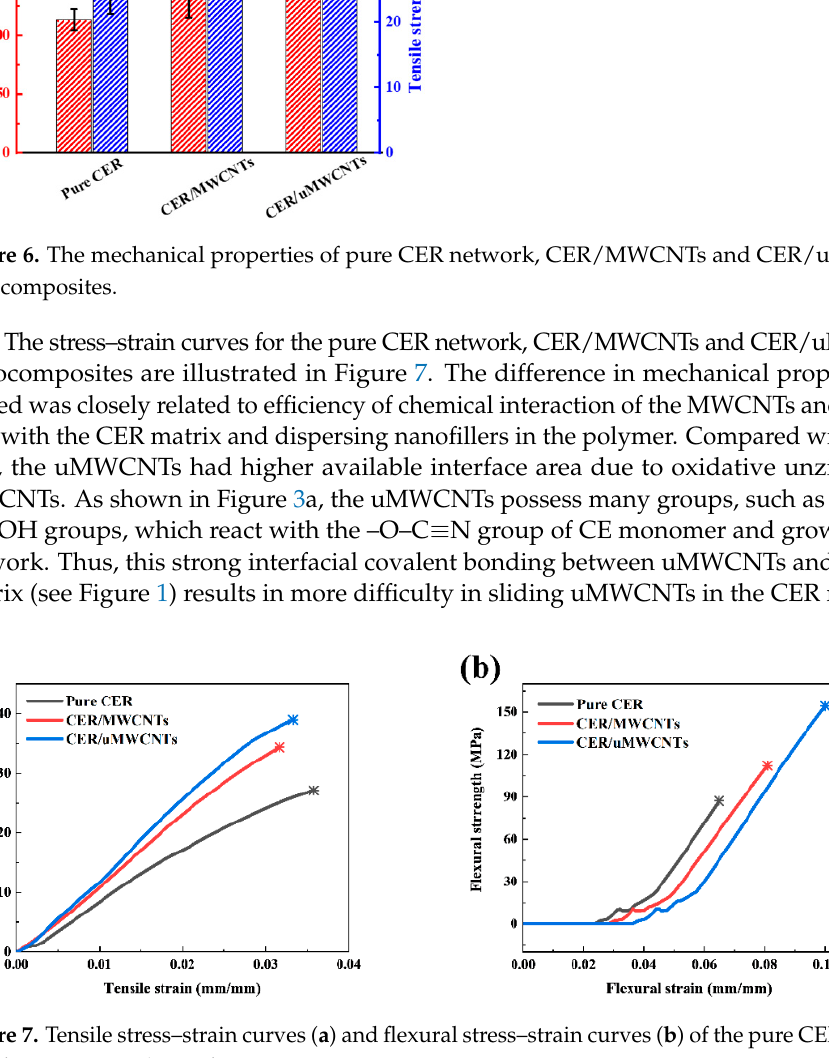
Figure 7. Tensile stress–strain curves ( a ) and flexural stress–strain curves ( b ) of the pure CER network, CER/MWCNTs and CER/uMWCNTs nanocomposites.